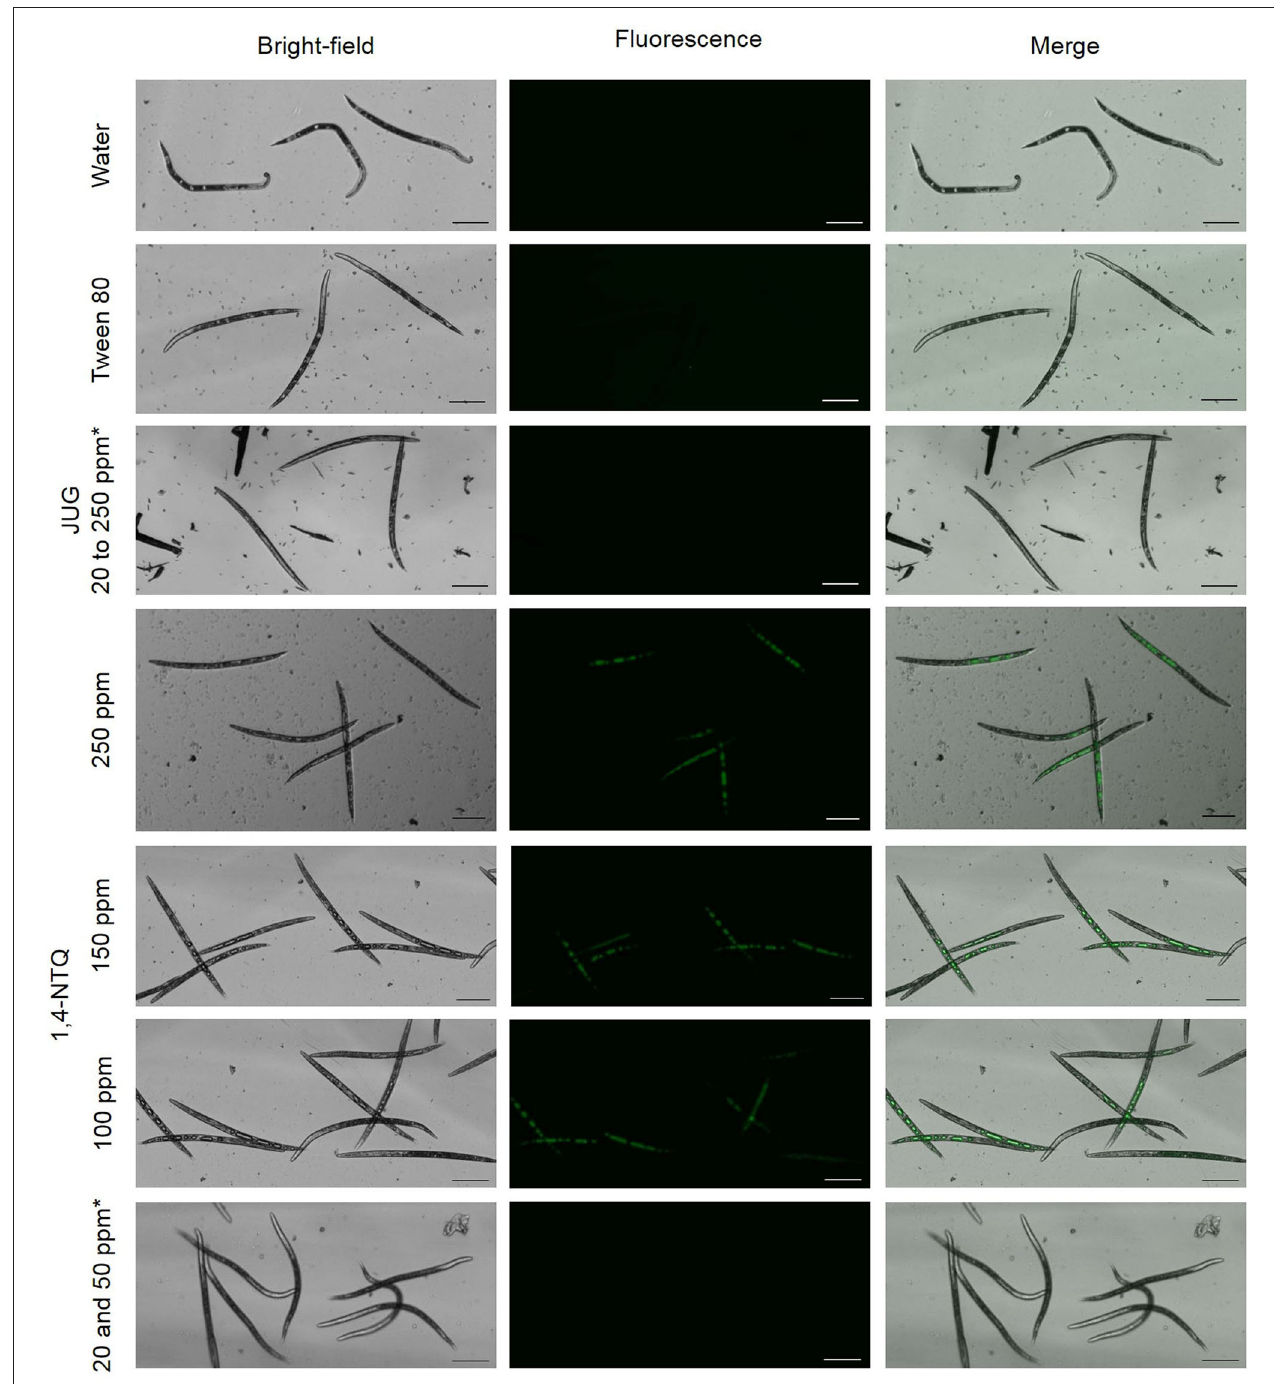
FIGURE 5 | In vitro production of reactive oxygen species in Meloidogyne luci second-stage juveniles, after exposure for 3 days to juglone (JUG) and 1,4-naphthoquinone (1,4-NTQ) at different concentrations. *Similar results were obtained for referred concentrations; images presented correspond to the higher concentration. Scale bars = 100 µ